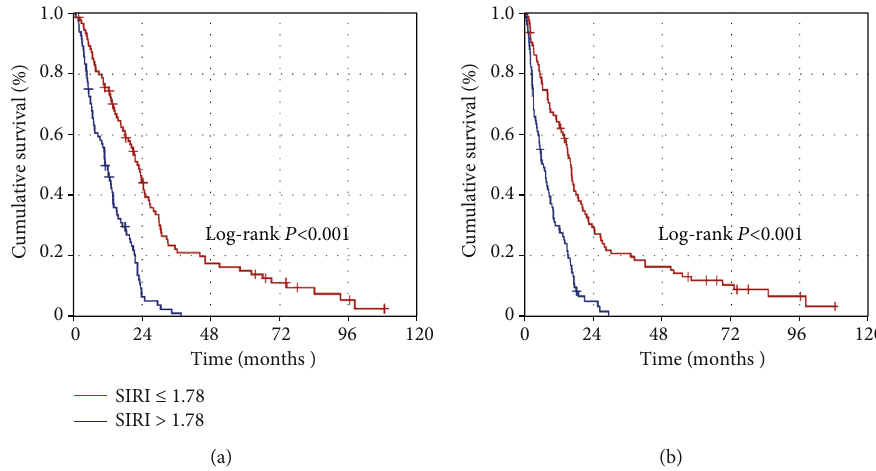
Figure 2: Comparative results of the progression-free- and overall survival outcomes per systemic immune response index (SIRI) cohorts: SIRI ≤ 1 : 78 (red line) and > 0.75 (dark blue